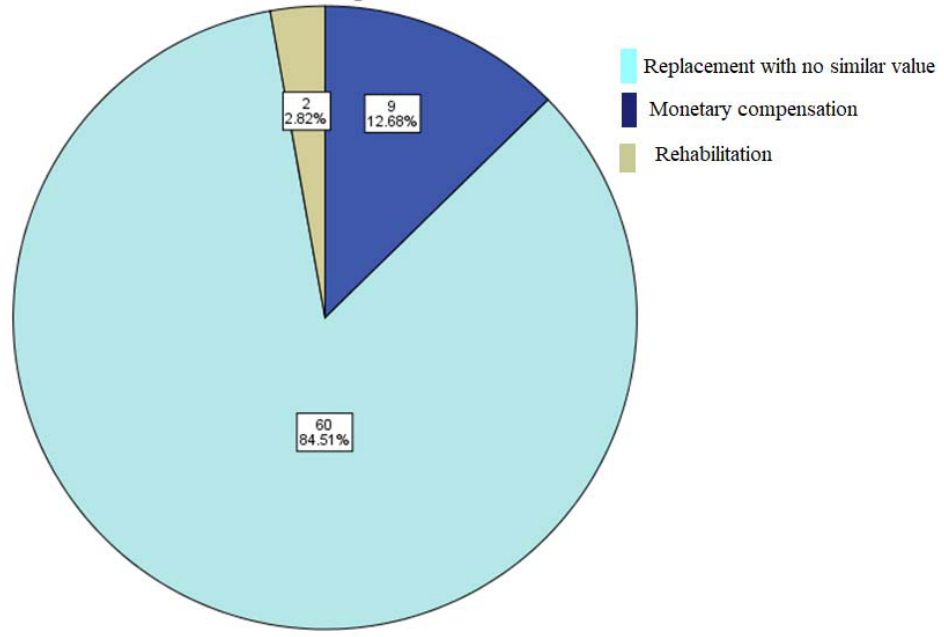
Figure 6. Enhancement and mitigation measures for the loss of farmland.